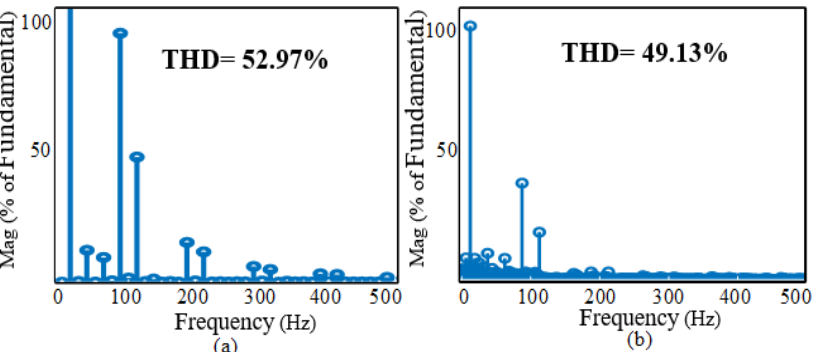
Figure 14. Harmonics spectrum for voltage and current of one − fourth frequency conversion of input